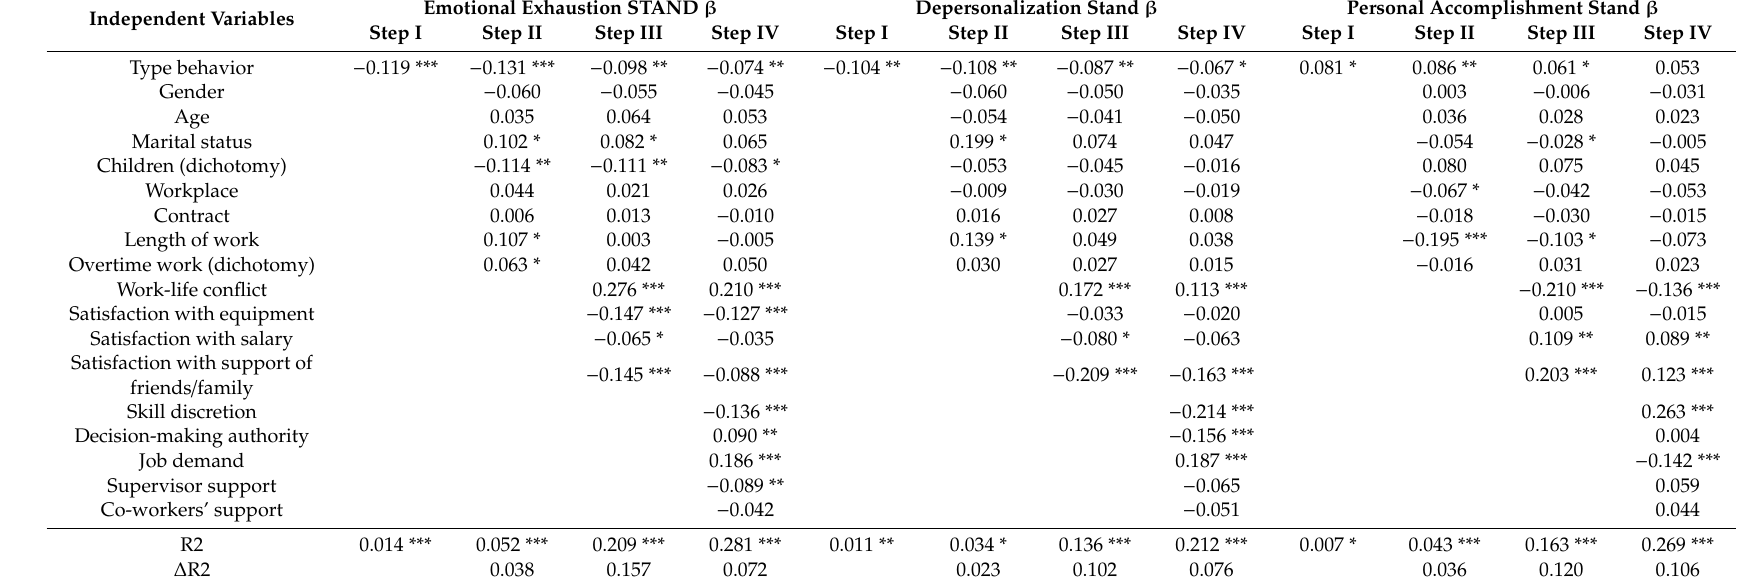
Table 6. Factors associated with the MBI-HSS score (hierarchical linear